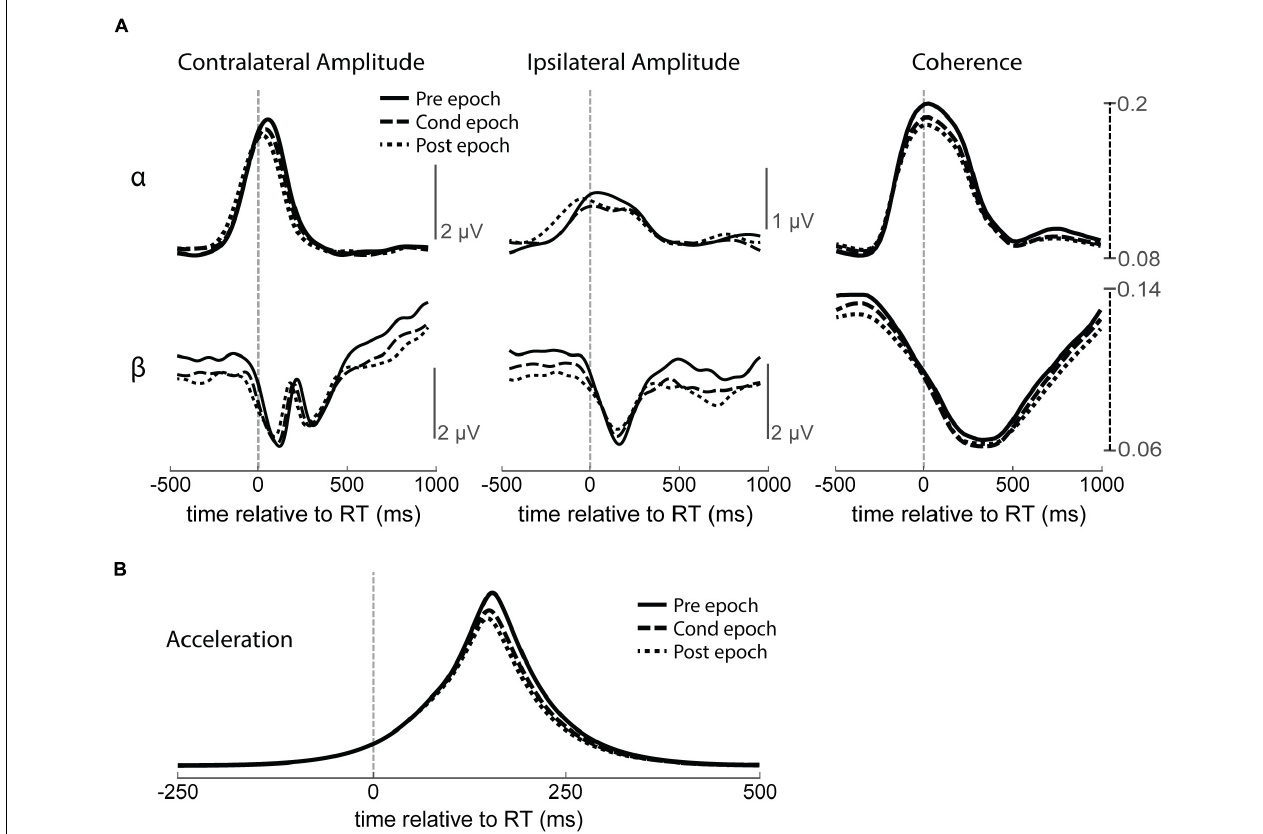
FIGURE 10 | Change in amplitude and coherence over time with no stimulation. (A) RT-aligned alpha ( α , top) and beta ( β , bottom) intrahemispheric amplitude and interhemispheric coherence for all three epochs of no stimulation control experiments. Contralateral and ipsilateral refers to the hemisphere relative to movement. (B) Accelerometer traces showing larger movements during the Pre epoch compared to the Cond or Post epochs during no stimulation control experiments.